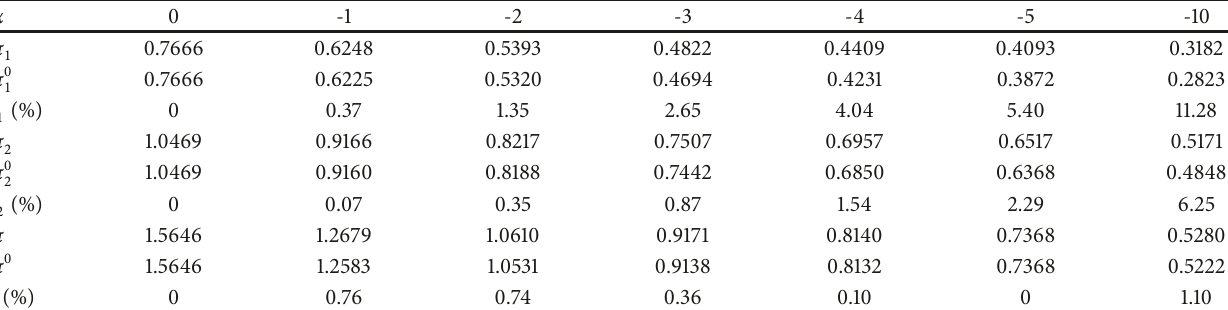
Table 1: The comparison of revenues whether considering network effect.